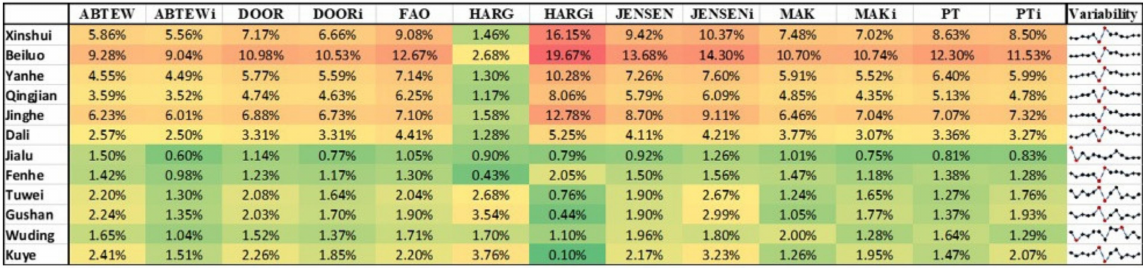
Figure A4. Standard deviation of quantitative contribution to streamflow change calculated by fixed E 0 estimations and varied Budyko-based methods.